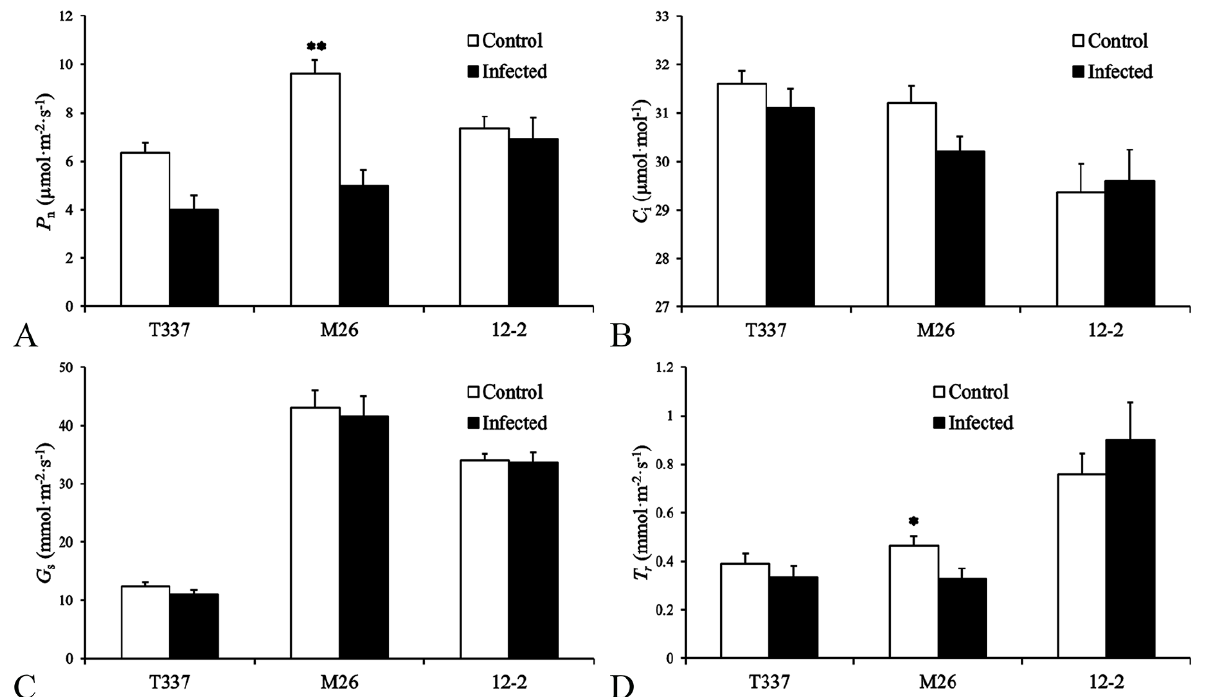
Figure 3. Effects of F. proliferatum MR5 on leaf photosynthetic parameters: ( A ) P n ; ( B ) C i ; ( C ) G s ; ( D ) T r . The Student’s t -test was used to detect the differences between the control and infected treatments within a rootstock. * p < 0.05; ** p <